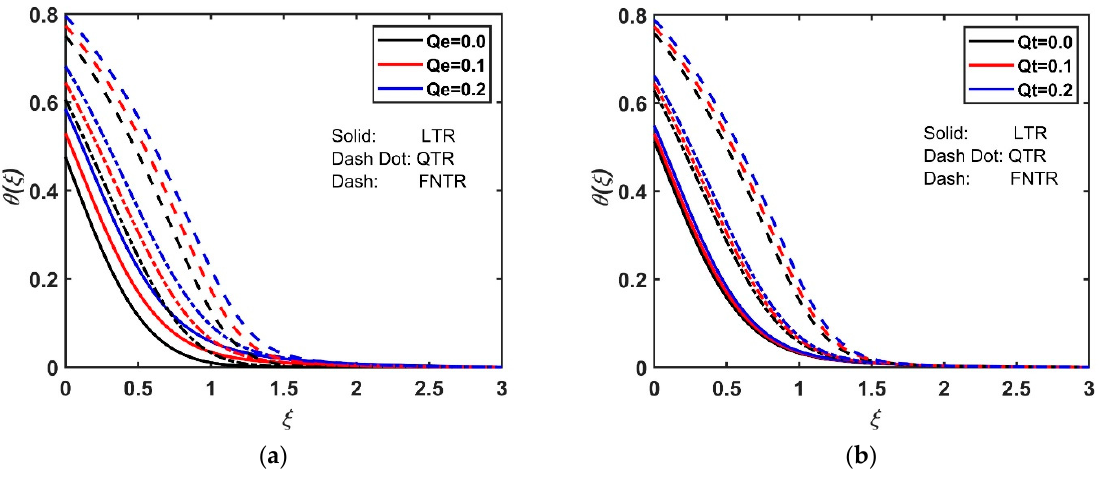
Figure 3. Impact of ( a ) 𝑄𝑒 on 𝜃(𝜉) , and ( b ) 𝑄𝑡 on 𝜃(𝜉) for the LTR, QTR and FNTR cases.